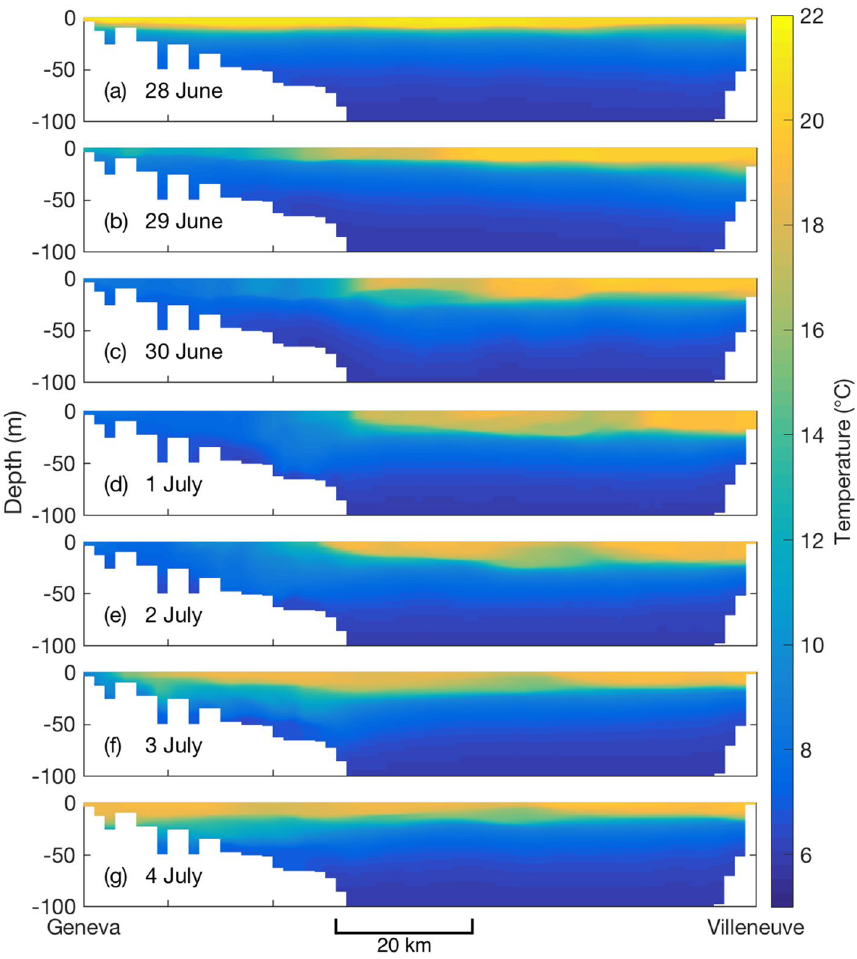
Figure 3. Upwelling event on June 28–July 4. Temperature profiles on the W–E transect at 1100UTC as simulated by Delft3D. Plots generated with Matlab 25 ; Panels assembled with Adobe Illustrator 26